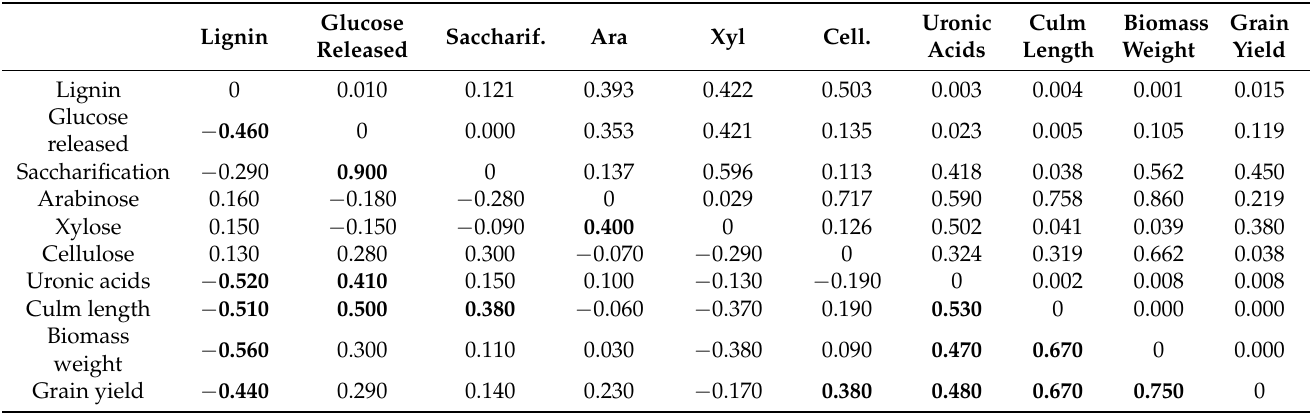
Table 5. Spearman’s correlation coefficient matrix. Pairwise correlation analyses were performed for all assayed genotypes. The panel above the diagonal shows p -values. The panel below the diagonal shows Spearman’s correlation coefficients (significant data are marked in